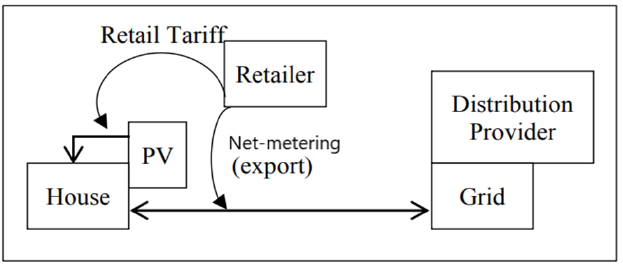
Figure 4. Net metering measurement method.